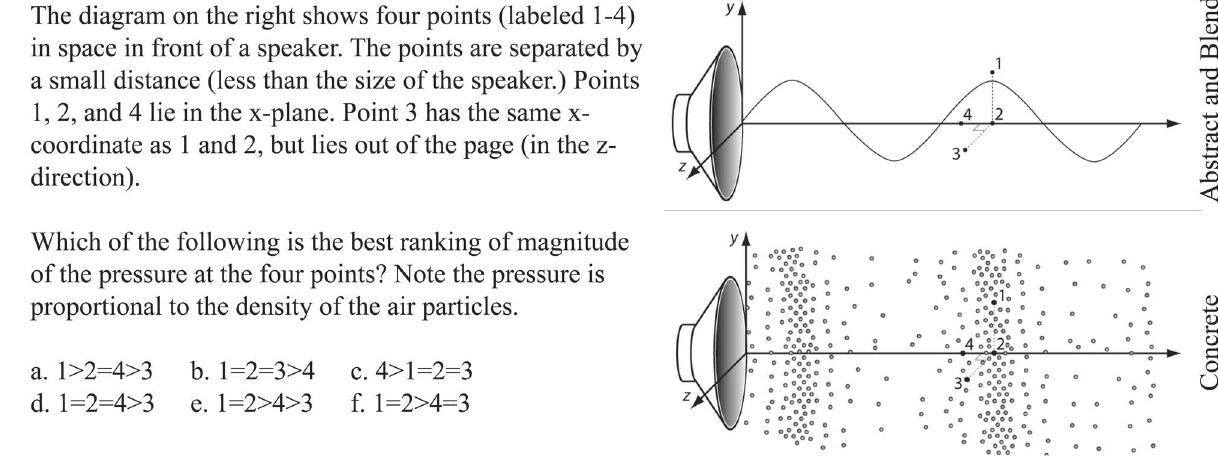
FIG. 9. Question 2 sound waves quiz. The same representation (cid:1) top (cid:2) was used for the abstract and blend groups. A different represen- tation (cid:1) bottom (cid:2) was used for the concrete